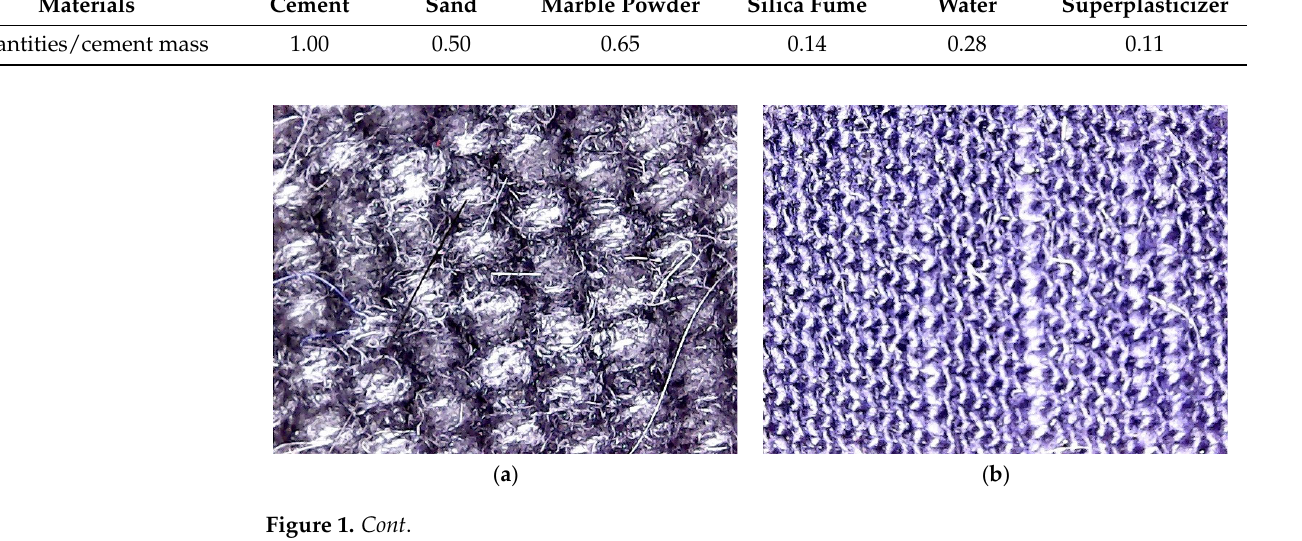
Table 2. Properties of high ‐ range water reducer.